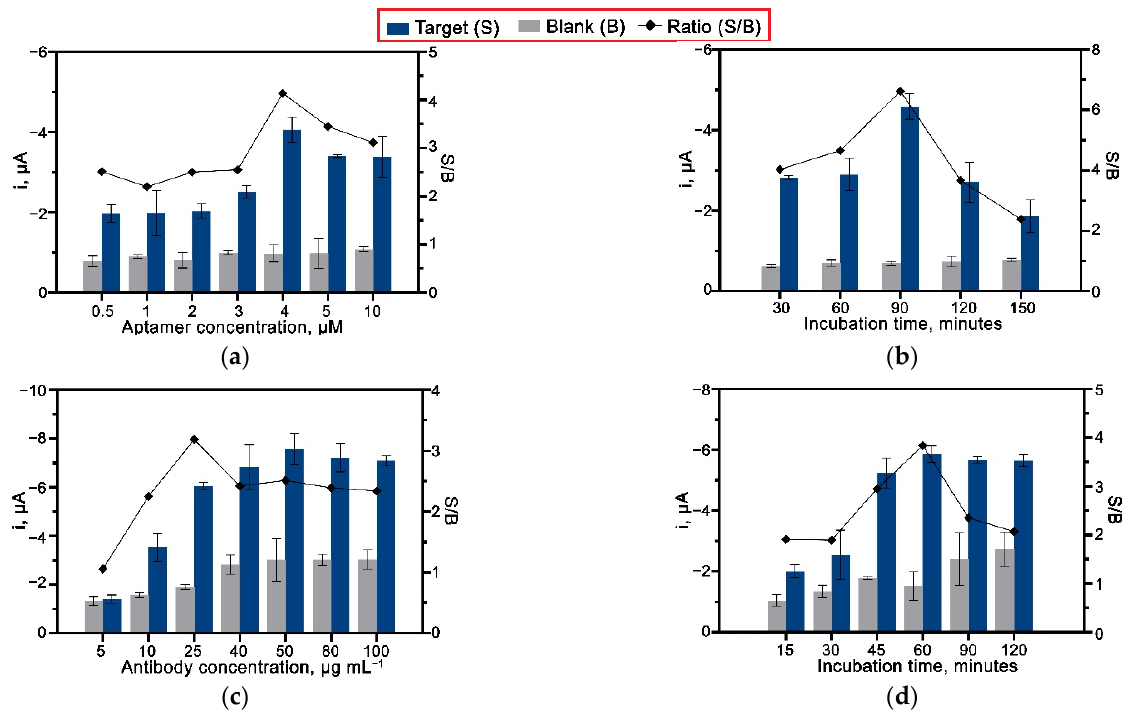
Figure 6. Optimization of aptasensor parameters, ( a ) concentration, and ( b ) incubation time of anti-MPT64 aptamer; ( c ) concentration and ( d ) incubation time of anti-MPT64 antibody ( n = 3).